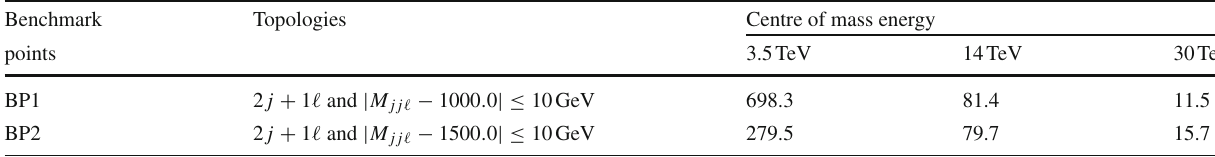
Fig. 27 Limits obtained via the inclusive measurements from N 0 N ± , N + N − productions for the Yukawa coupling versus Type-III fermion mass for the transverse ( a , c ) and the longitudinal ( b , d ) decay lengths for the finalstates containing at least one displaced Higgs boson with 14 ( a , b ), 100 ( c , d ) TeV centre of mass energies at the LHC/FCC with integrated luminosities of 3000 and 300 fb − 1 respectively